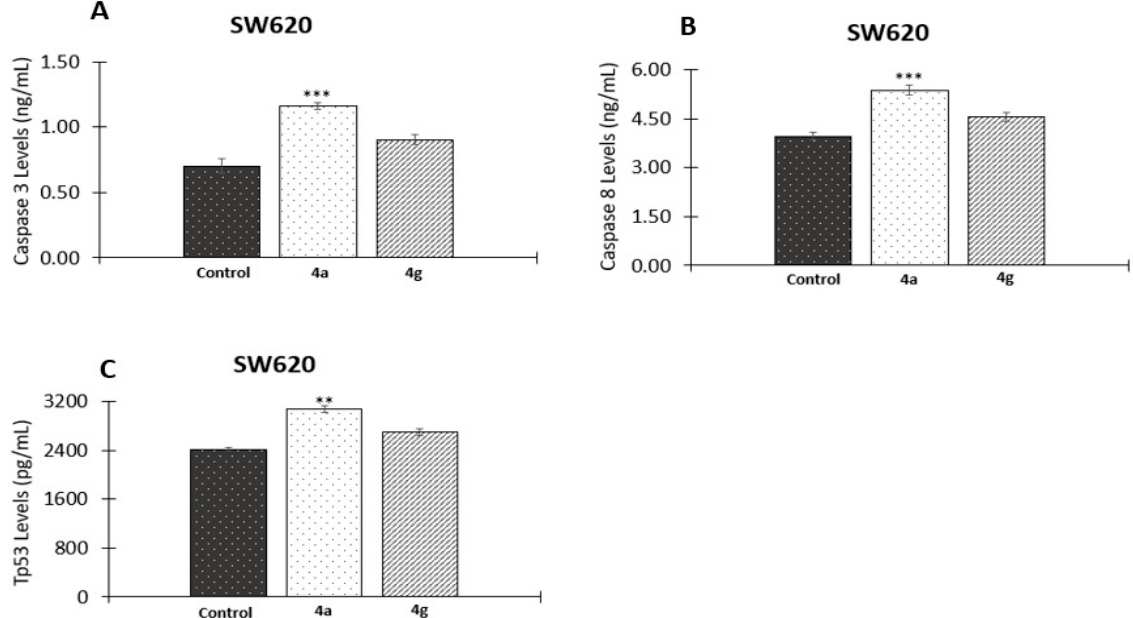
Figure 8. Determination of apoptotic biomarkers in SW620 cells. Protein levels of caspase-3 ( A ), caspase 8 ( B ) and tumor suppressor protein p53 ( C ). DMSO (1%) was used as control. Results are the mean ± SE of two independent experiments. p values lower than 0.05 were considered statistically significant (** p < 0.01; *** p <